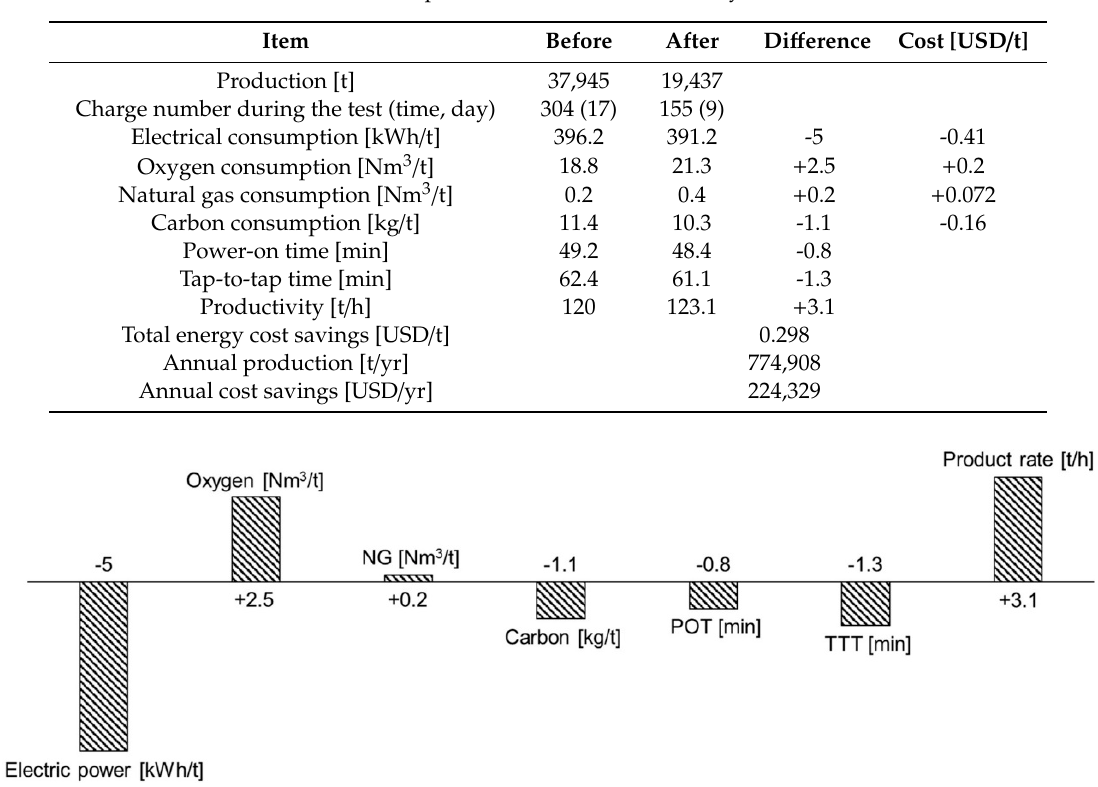
Figure 7. Differences in electricity, oxygen, natural gas, carbon, power-on-time, tap-to-tap time, and productivity before and after system modification.